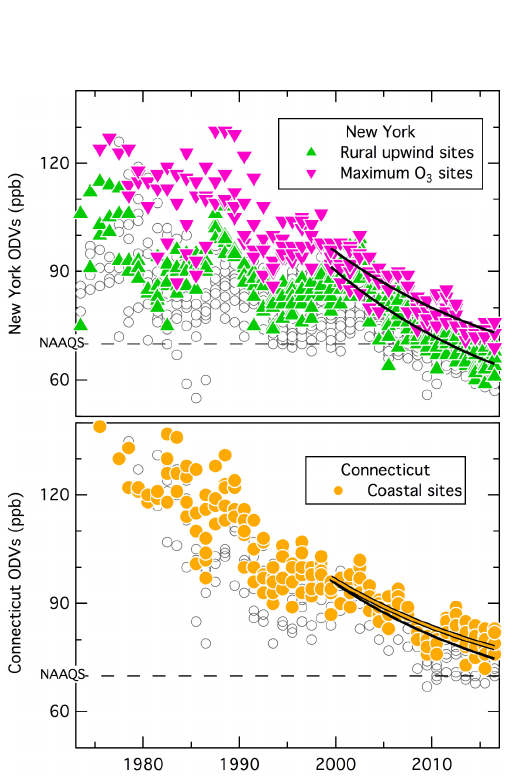
Figure 5. Time series of all ODVs (grey symbols) reported from all monitoring sites in New York and Connecticut. The three sets of colored symbols indicate the results from groups of sites that are discussed in detail. The curves are fits of Eq. (1) to respective colored symbols and to all data points for Connecticut.